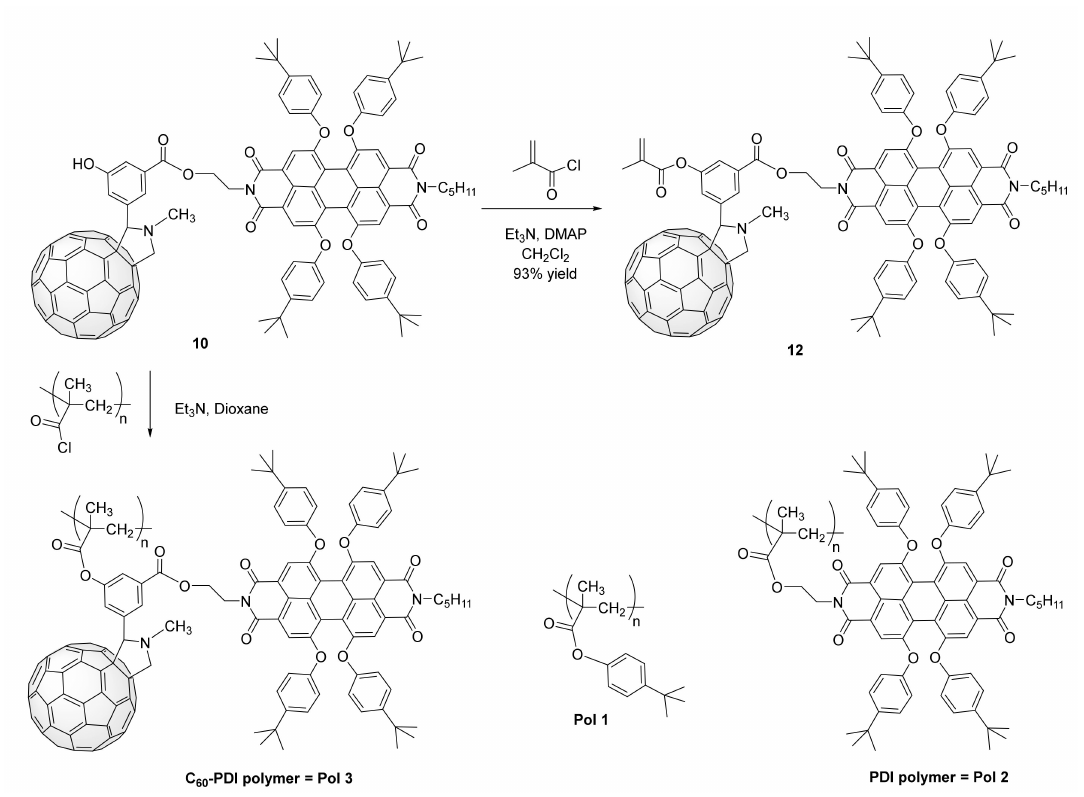
Scheme 14. Synthesis of dyad 12 , C 60 -PDI polymer Pol 3 , and PDI-based polymer Pol 2 , tert - butylphenol based polymer Pol 1 for